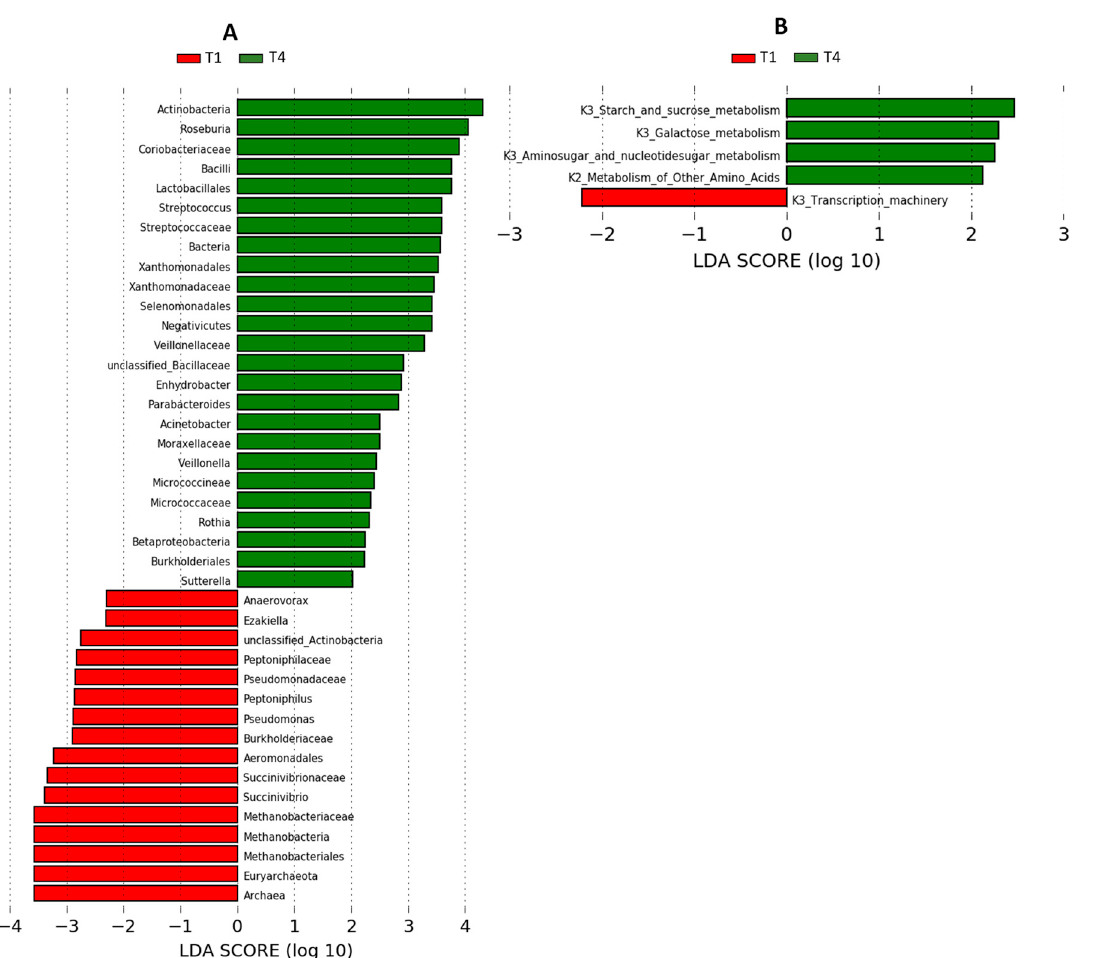
Figure 3. Linear discriminant analysis (LDA) effect size (LEfSe) analysis of gut microbiota that shows different abundances through postpartum in ( A ) maternal fecal microbiome and ( B ) inferred functional capacity of the fecal microbiome. Positive LDA scores (green bars) are enriched after the lactation stage (T4, 12 months after delivery) while negative LDA scores (red bars) are enriched in the early lactation stage (T1, 3 weeks after delivery). The microbial taxa and functions shown in the Figure have a LDA score higher than 2.